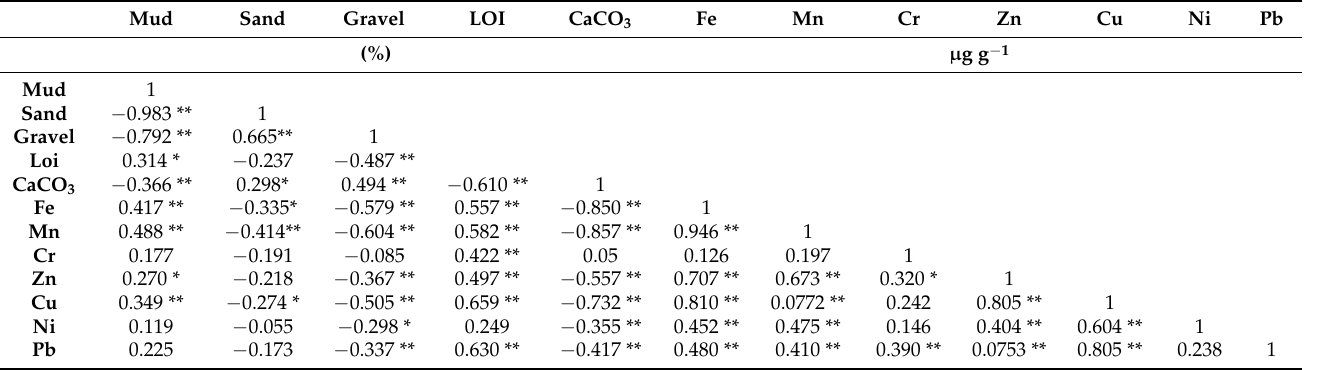
Table 2. Correlation matrix (core length = 220 cm, n =